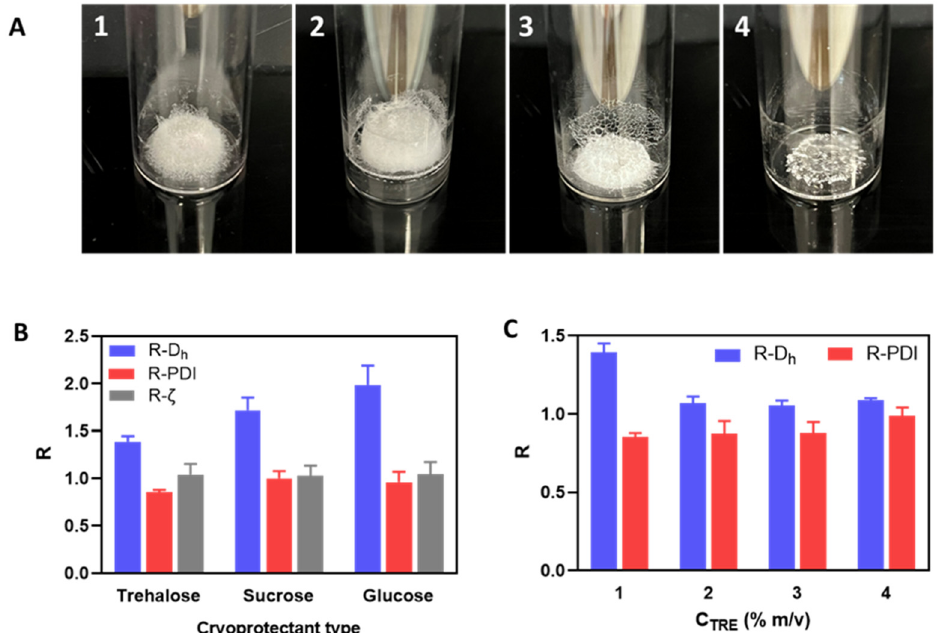
Figure 2. ( A ): Freeze-dried cakes of HA/DEAE-D PEC-NGs at C P = 0.5 g.L − 1 and n − /n+ = 2.5 without cryoprotectant ( A1 ), or with 1% m/v trehalose ( A2 ), sucrose ( A3 ), or glucose ( A4 ). ( B , C ): Change factor R (value after reconstitution: before freeze-drying) of PEC-NG characteristics when freeze-dried with different types of cryoprotectant at 1% m/v ( B ) or with trehalose at different concentrations C TRE ( C ) ( n ≥ 3). D h : hydrodynamic diameter, PDI: polydispersity index, ζ : zeta potential.